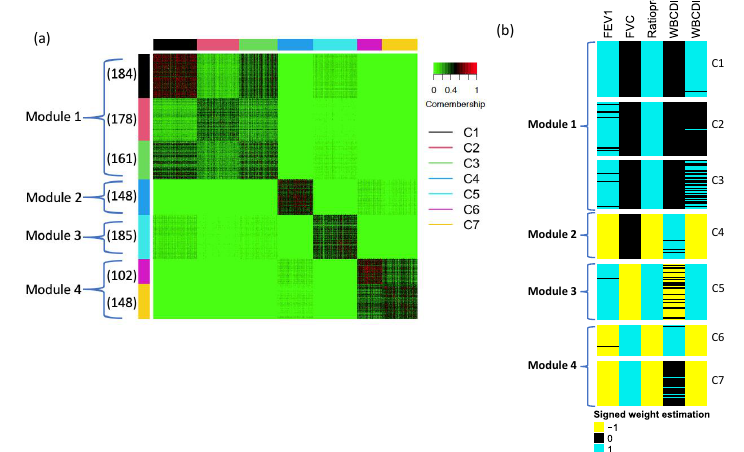
Figure 1. ( a ) The heatmap of comembership matrix of seven clusters identified in the complex lung diseases dataset. Red color means two genes are close. The number in the parentheses indicates the sample size of each cluster. ( b ) The weight estimation of each gene (blue represents 1, black represents 0 and yellow represents −